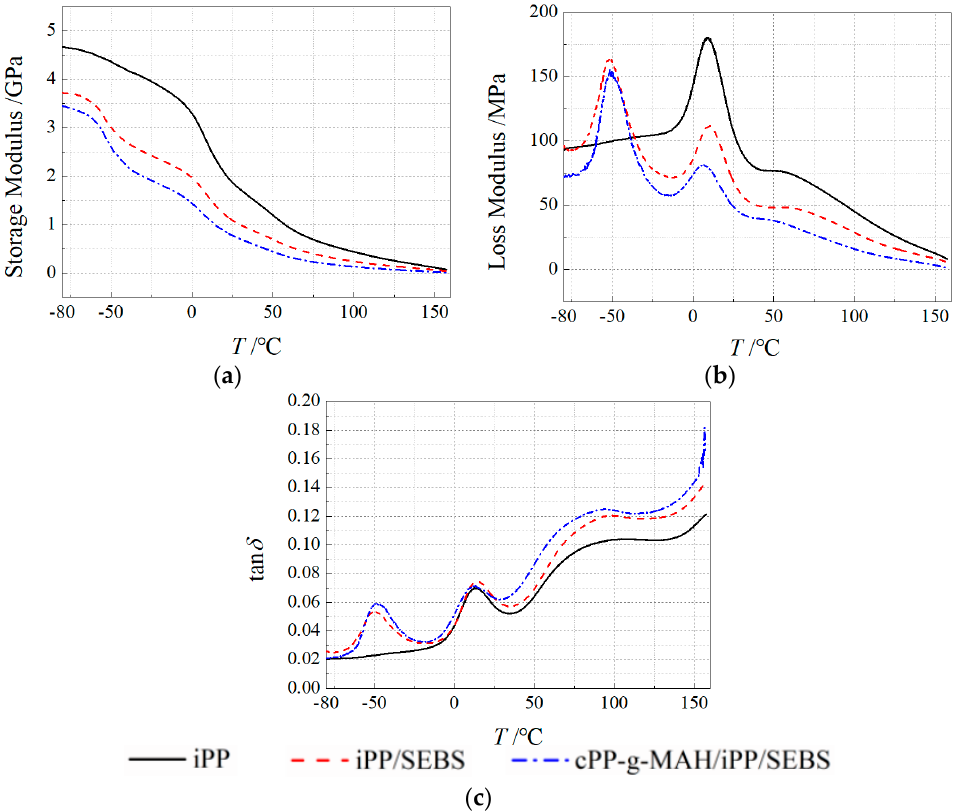
Figure 4. The dynamic mechanical analysis (DMA) thermal spectra of ( a ) storage modulus, ( b ) loss modulus, and ( c ) tan δ for iPP and its composites.